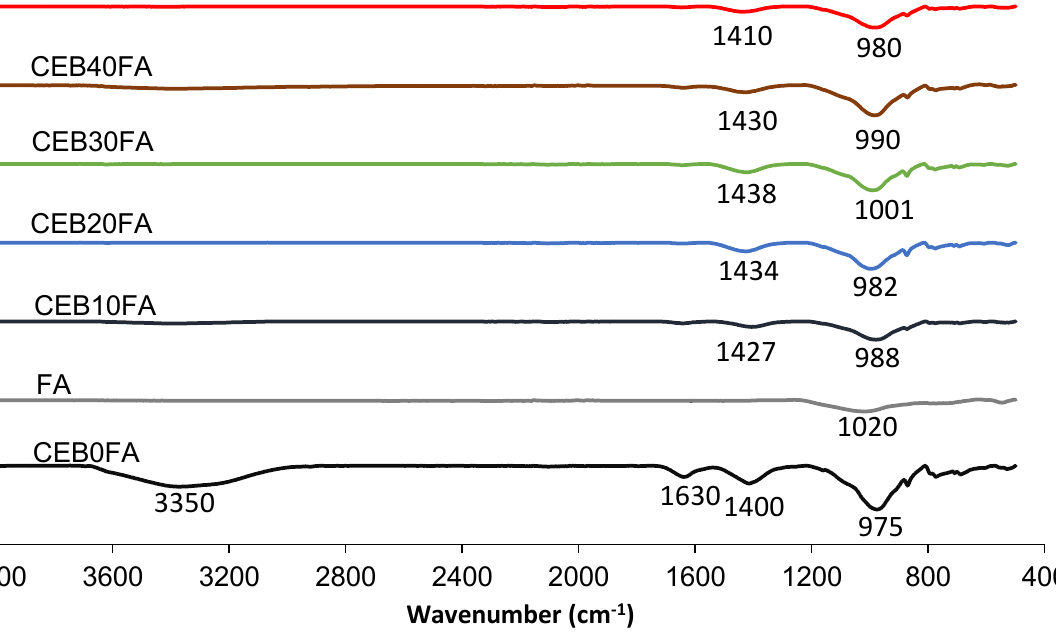
Figure 6 . FTIR spectra of fly ash and different CEBs. Figure 6. FTIR spectra of fly ash and different